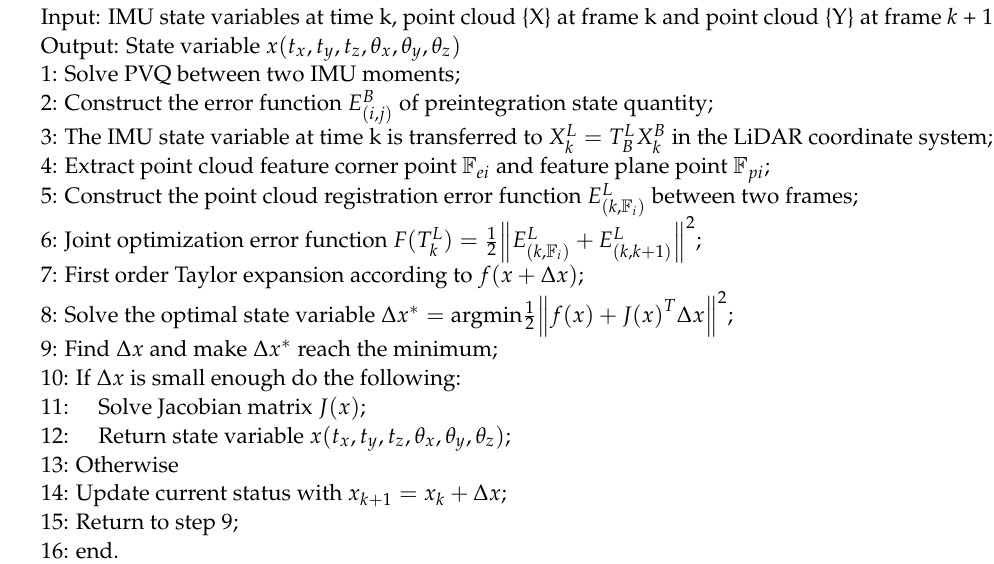
Algorithm 1: LiDAR point cloud registration